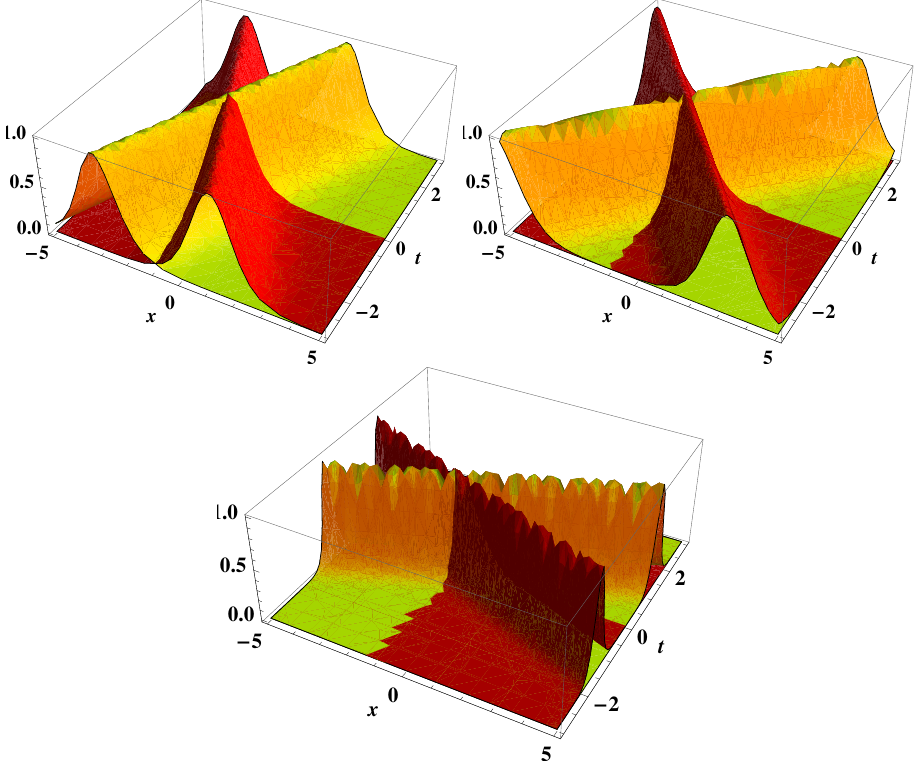
Figure 1. Interaction of the two-wave solutions given by (16) upon increasing the phase velocity, for s = 0.5, 1, 3, respectively. Here p =